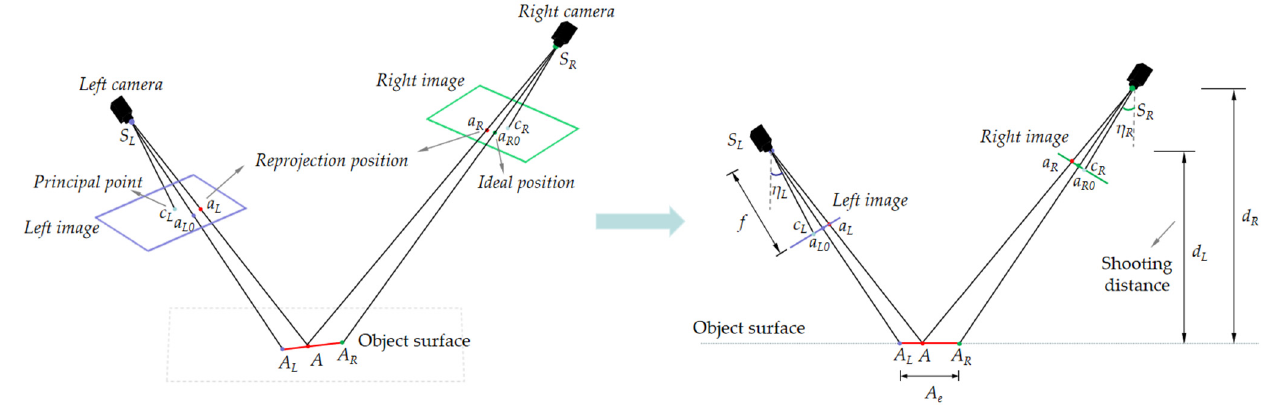
Figure 2. Aerotriangulation of the stereo vision system in space ( left ) and plane ( right ).